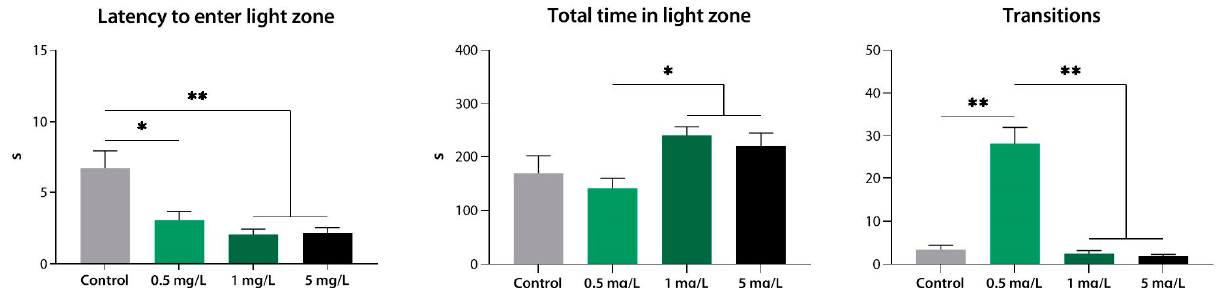
Figure 12. Compound 4 ( 33a ) at low concentrations induces an anxiolytic-like effect in zebrafish, as assessed using the light/dark box test. *, p < 0.05; **, p <